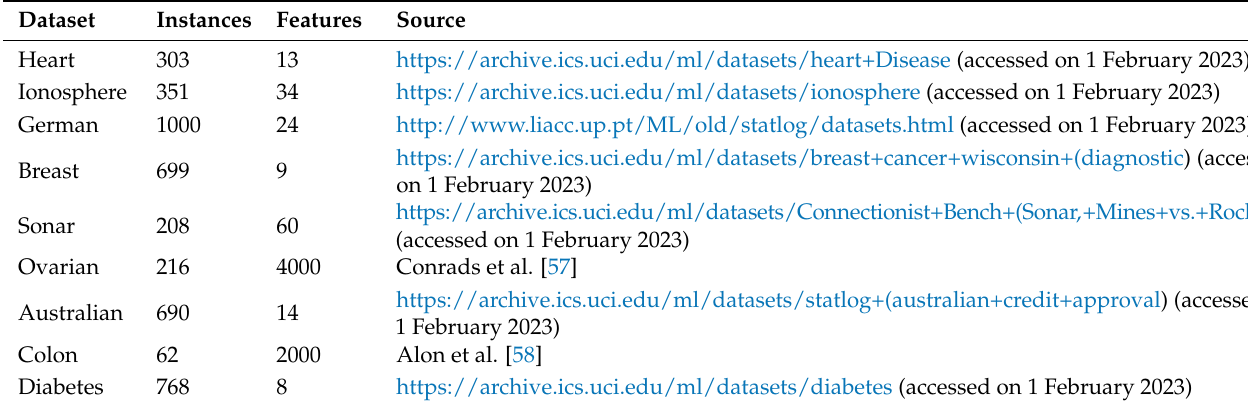
Table 1. Description of the binary